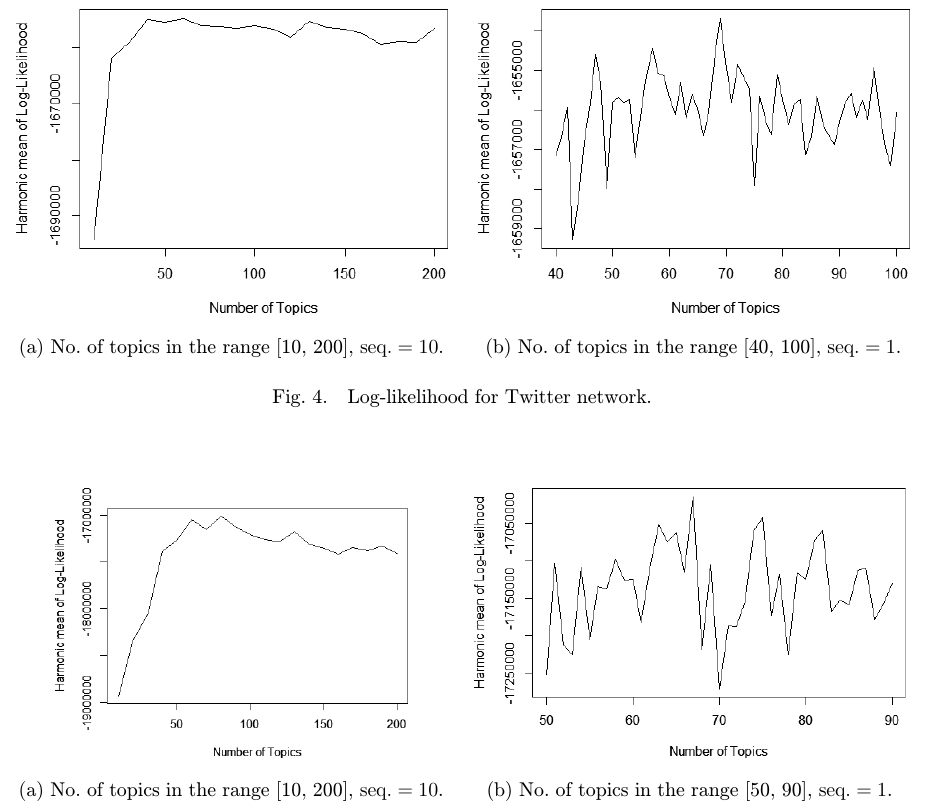
Fig. 5. Log-likelihood for